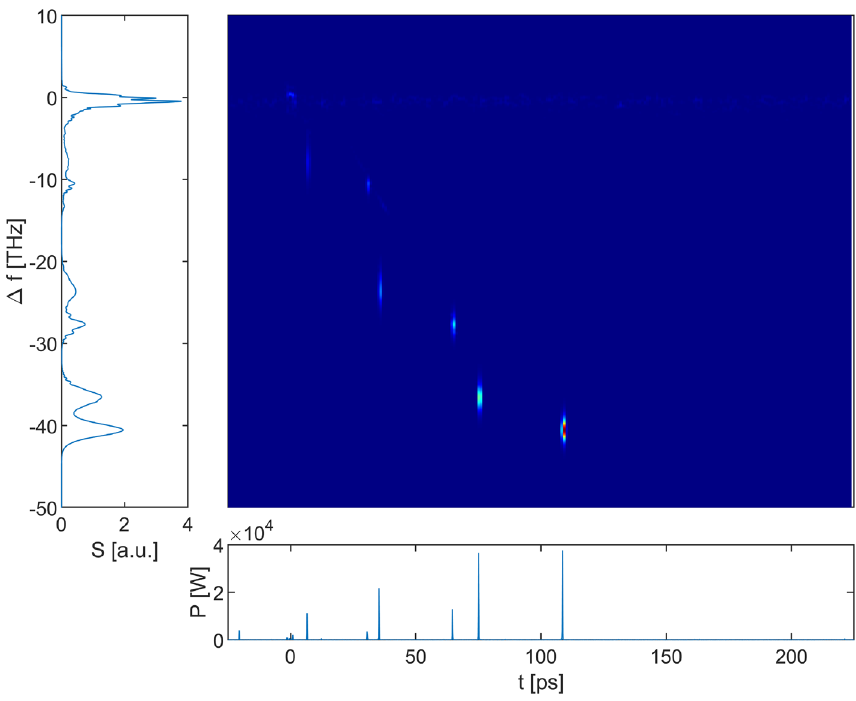
Figure 9. Spectrogram at the output of the